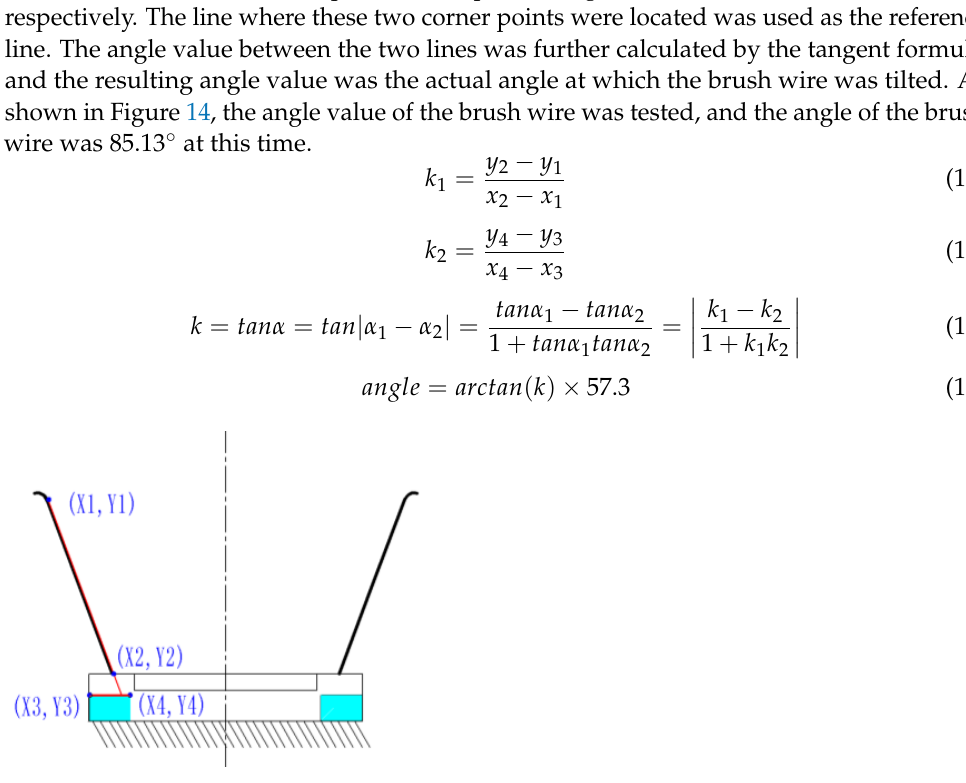
Figure 12. Brush wire corner point and edge straight line inspection diagram.